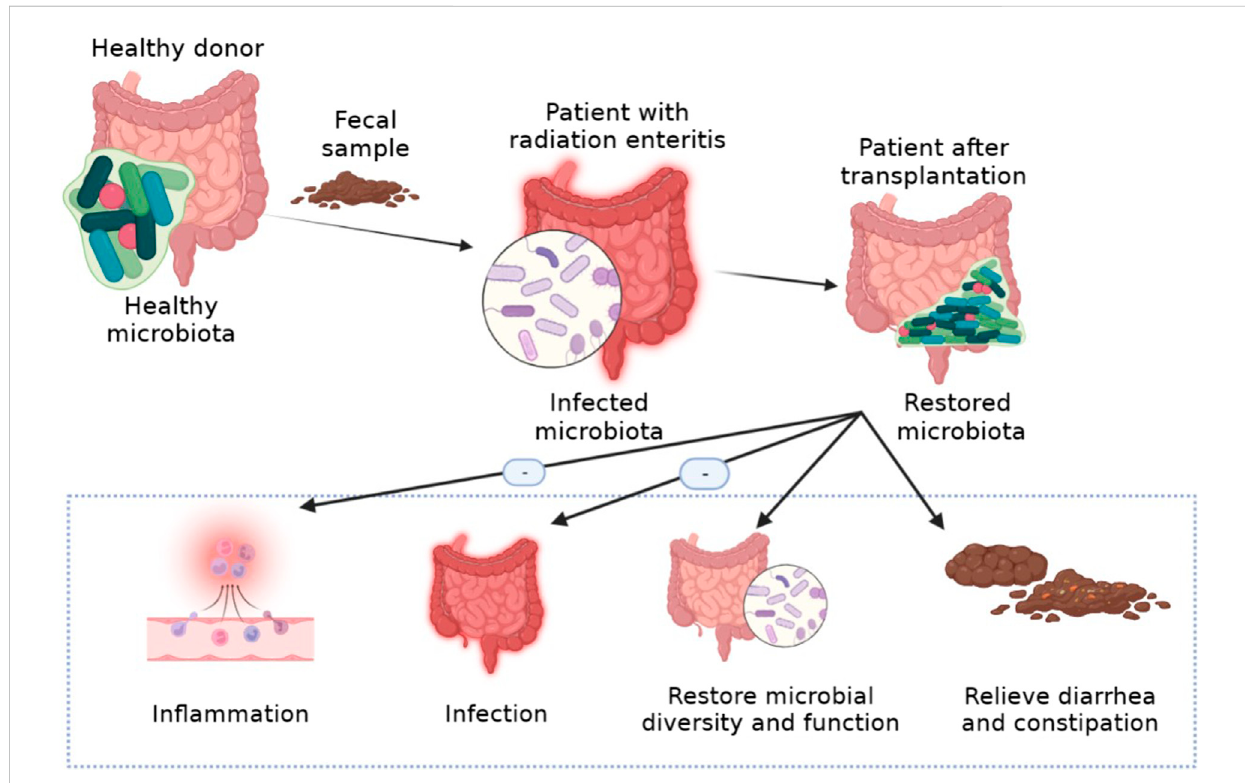
FIGURE 5 The treatment of FMT for radiation